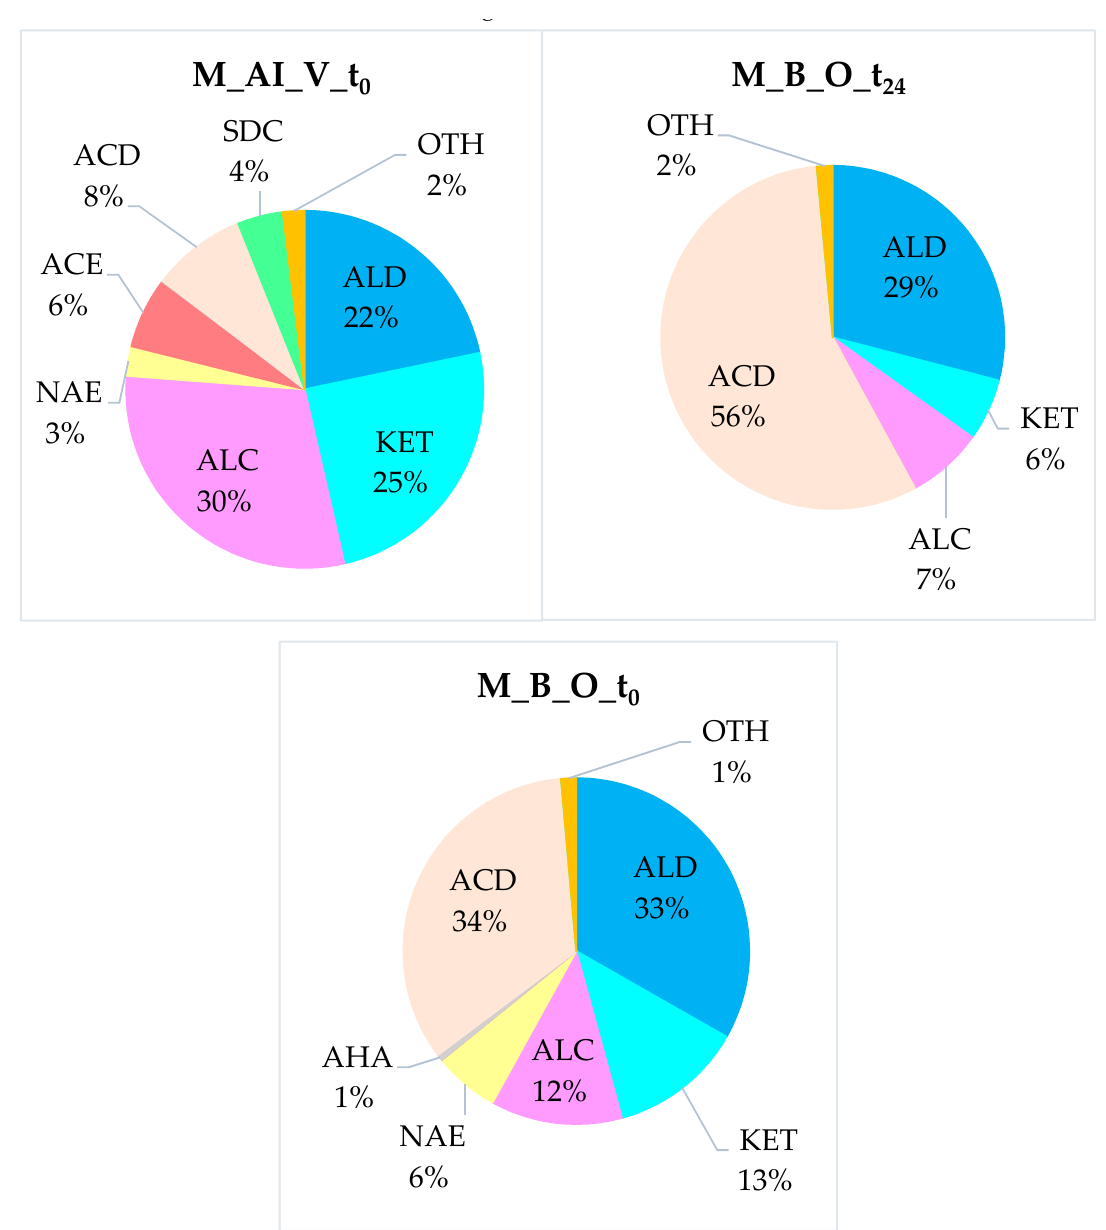
Figure 8. Graphical representation of the relative percentage area of the compound classes, identified in the HS-SPME-GC-MS analysis of the DF samples obtained from winter melon pomace.